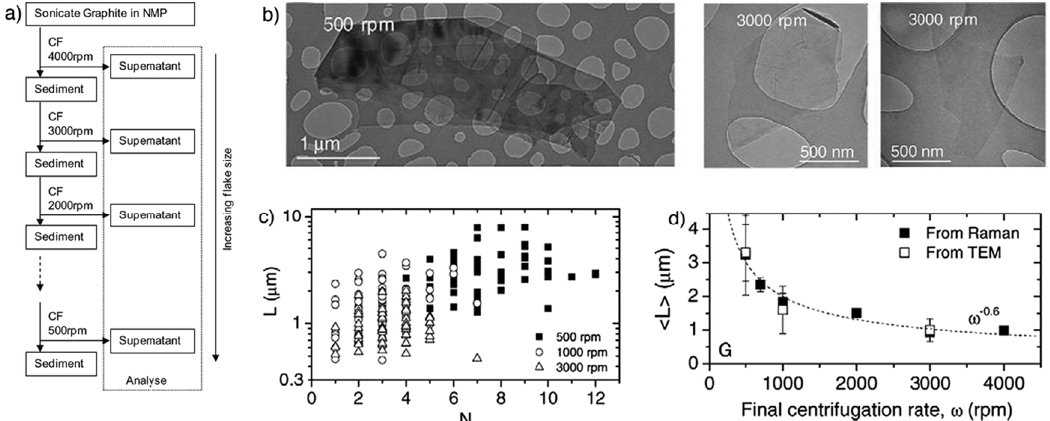
Figure 7. ( a ) Schematic representation of the flake separation process; ( b ) TEM images of flakes prepared at final centrifugation rates of 5000 rpm and 3000 rpm; ( c ) individual flake length plotted versus estimated flake thickness (number of monolayers, N) for dispersions with final centrifugation rates of 500, 1000, and 3000 rpm; ( d ) mean flake size as measured from TEM images. Reproduced from [41]. Copyright Elsevier,